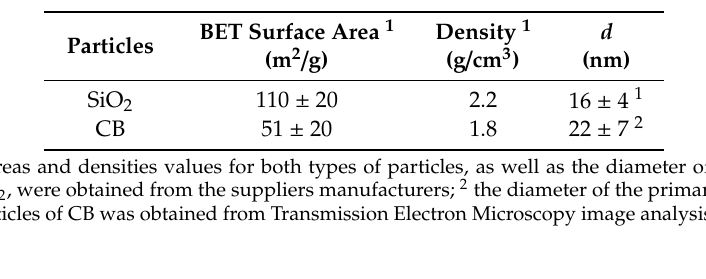
Table 1. Physico-chemical characteristics of the used